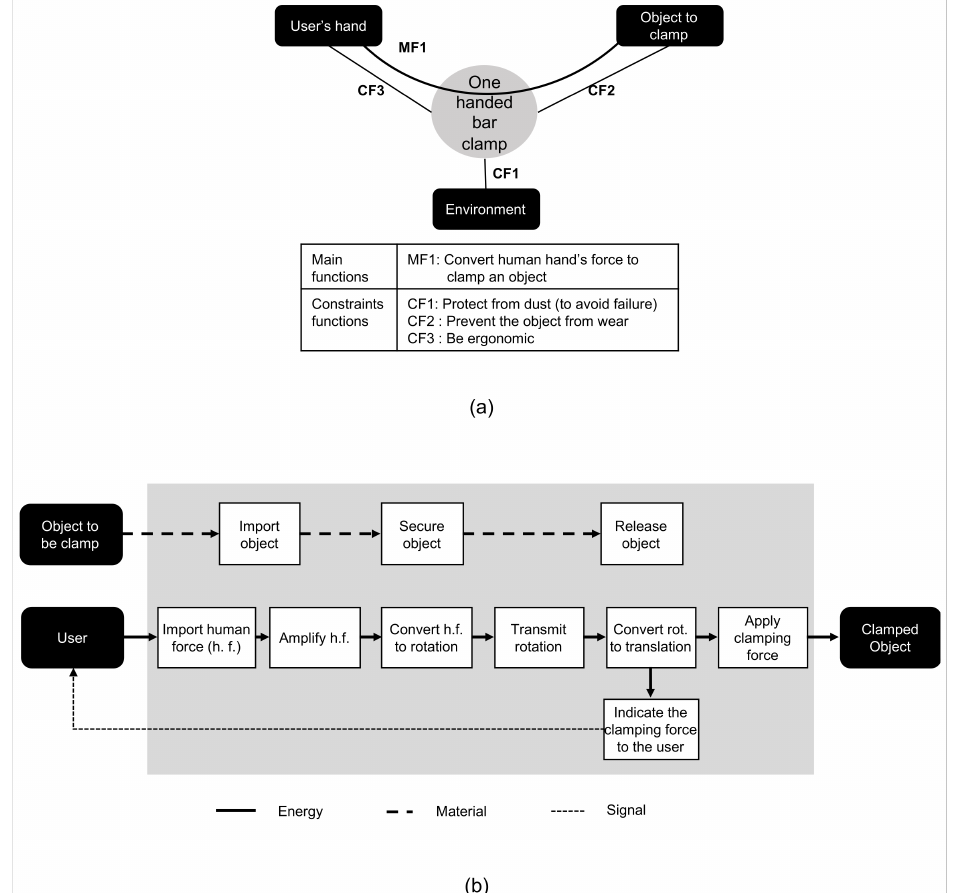
Figure 2. Clamp’s functional analysis. ( a ) External functional analysis; ( b ) Functional